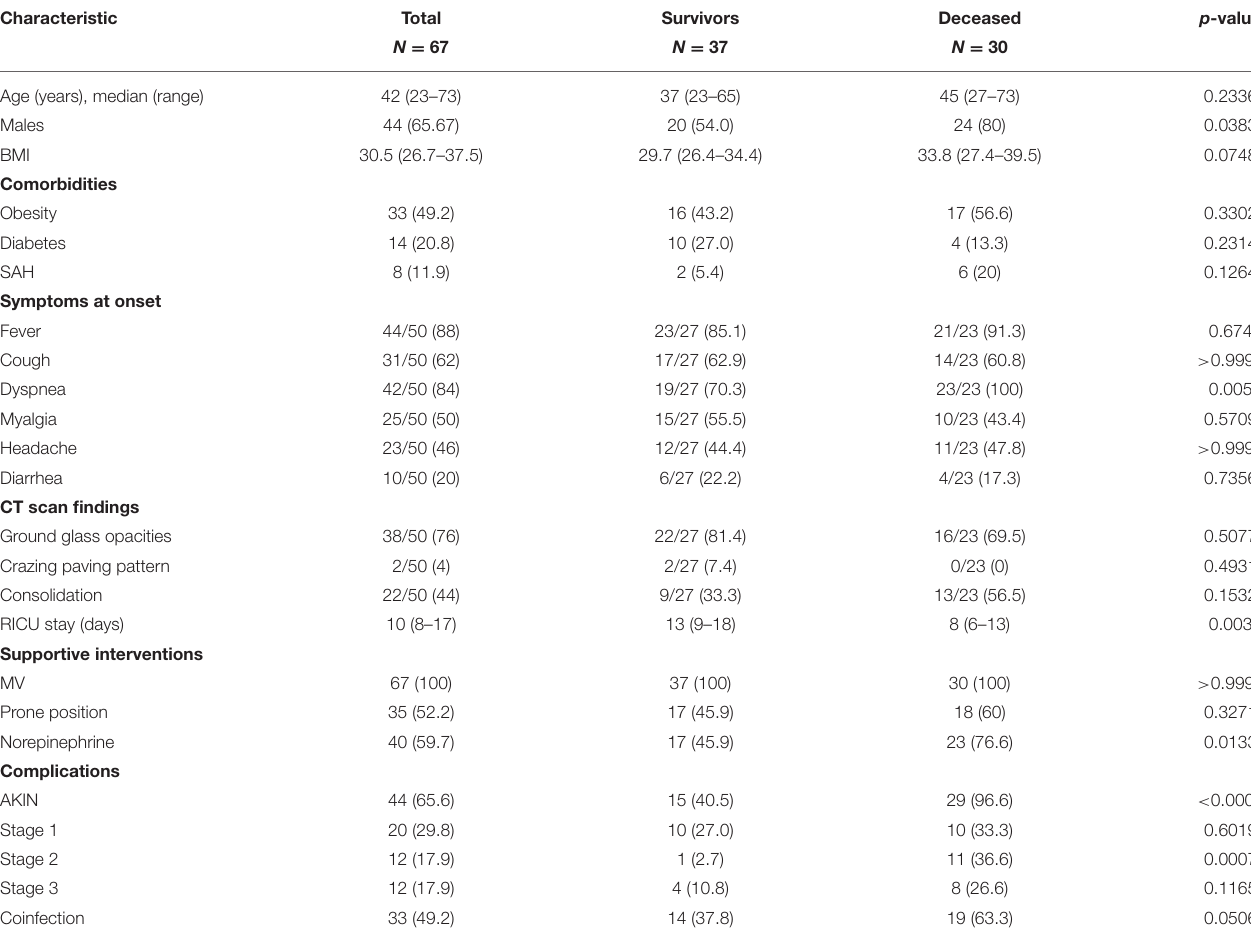
TABLE 2 | Clinical characteristics of critically ill COVID-19 patients.